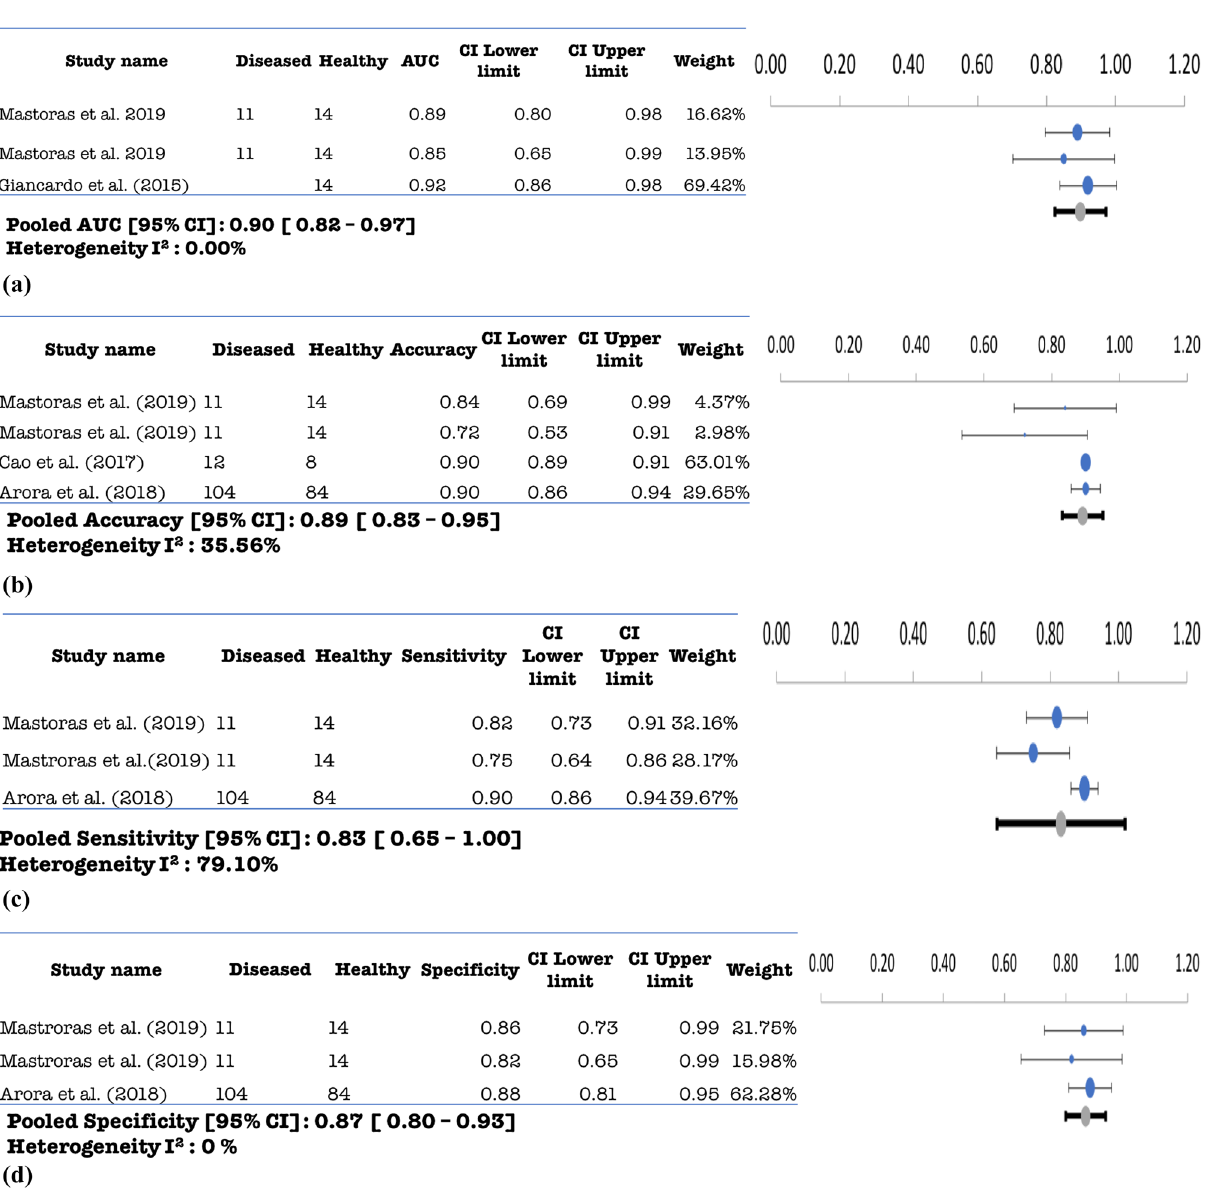
Figure 4. ( a ) Pooled AUC with 95% CI for psychiatric disorder studies. ( b ) Pooled Accuracy with 95% CI for psychiatric disorder studies. ( c) Pooled Sensitivity with 95% CI for psychiatric disorder studies. ( d ) Pooled Specificity with 95% CI for psychiatric disorder